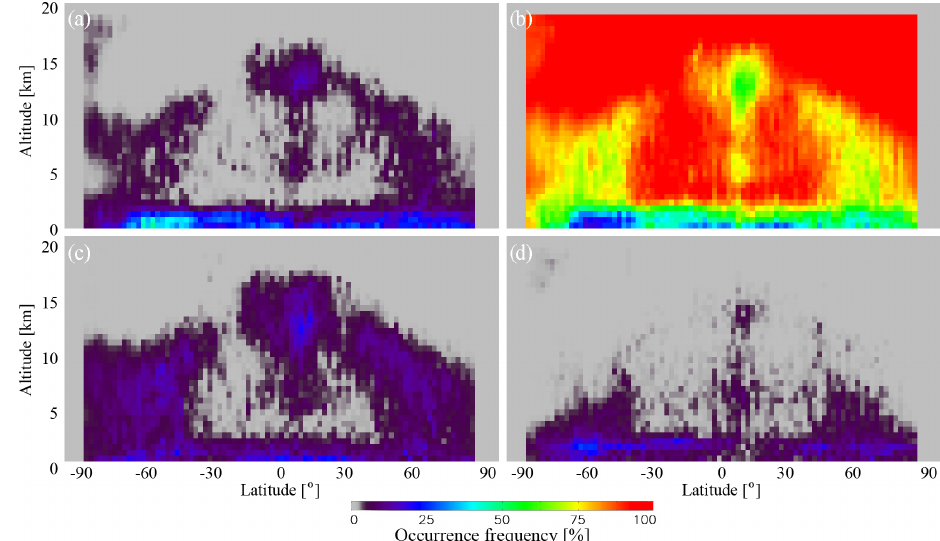
Figure 9. Occurrence frequency for collocated observations: (a) both CALIOP and ALADIN detected a cloud ( R YES_YES ( lat ,z) ); (b) neither CALIOP nor ALADIN detected a cloud ( R NO_NO ( lat ,z)) ; (c) CALIOP detected a cloud, whereas ALADIN missed a cloud ( R YES_NO ( lat ,z) ; and (d) CALIOP missed a cloud, whereas ALADIN detected a cloud ( R NO_YES ( lat ,z)